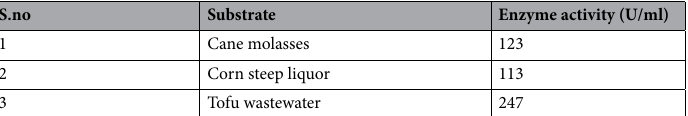
Table 2. Screening of various low-cost substrates and their corresponding amount of naringinase activity obtained.